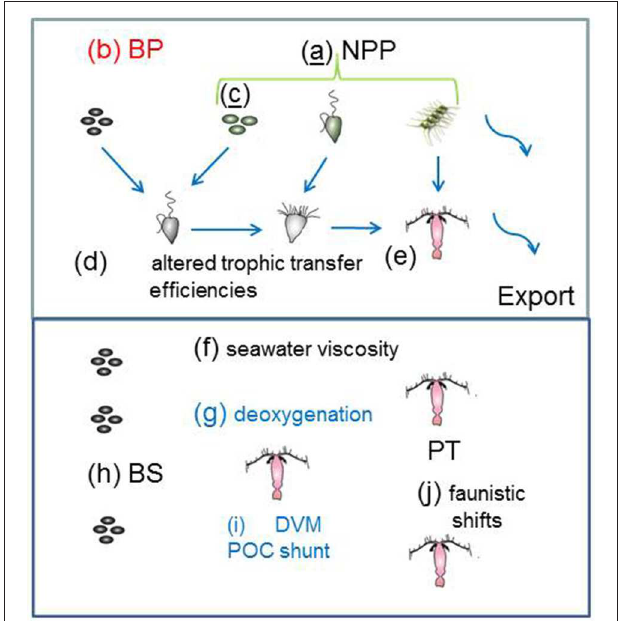
FIGURE 3 | Catalog of the climate-change model runs for the individual processes that influence the biological pump in both the surface and subsurface ocean. The schematic is as for Figure 1 with the exception of the letters (a) to (j) which denote changes to: (a) NPP; (b) BP; (c) phytoplankton community structure; (d) and (e) efficiency of trophic transfer of POC In the subsurface ocean (f) to (j) represent alteration of: (f) seawater viscosity; (g) deoxygenation; (h) microbial solubilization; (i) vertical migration; and (j) mesozooplankton trophic transfer efficiency. Colored letters denote processes mediated by: temperature (black); OA (red); “climate change”(blue); and those underlined have more than one form of mediation—e.g., model run (c) is influenced by temperature, CO 2 , salinity and/or iron supply (see Table 4